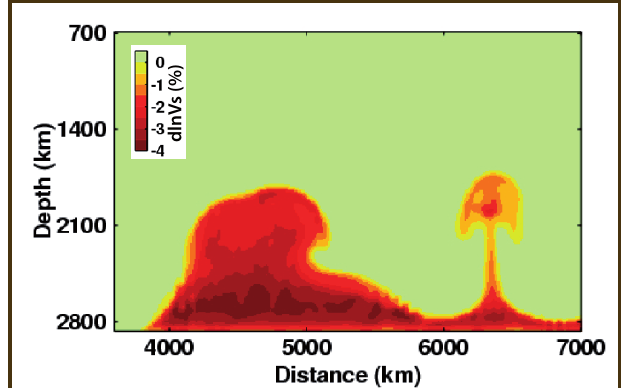
Figure 5. 2-D model showing the coexistence of plumes and super- plumes in time and space (Farnetani and Samuel, 2005). Colors cor- respond to calculated seismic velocity anomalies (see inset key for